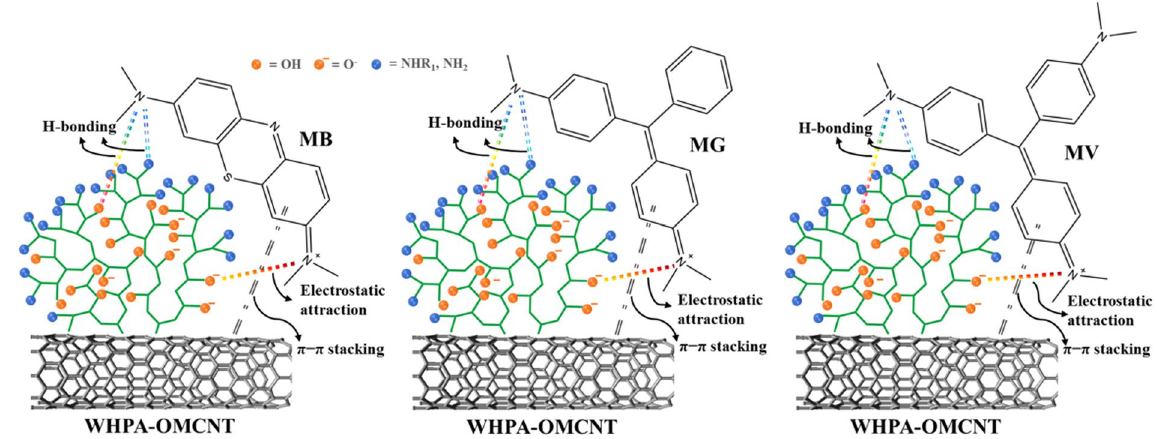
Figure 7. Proposed adsorption mechanism of MB, MG and MV adsorption onto